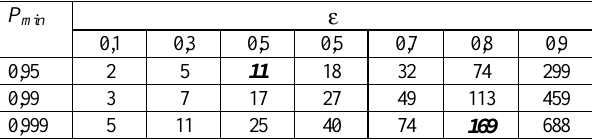
Table 1. Minimum number of trials n min to find at least one solution with minimum probability P min for an assumed percentage of errors